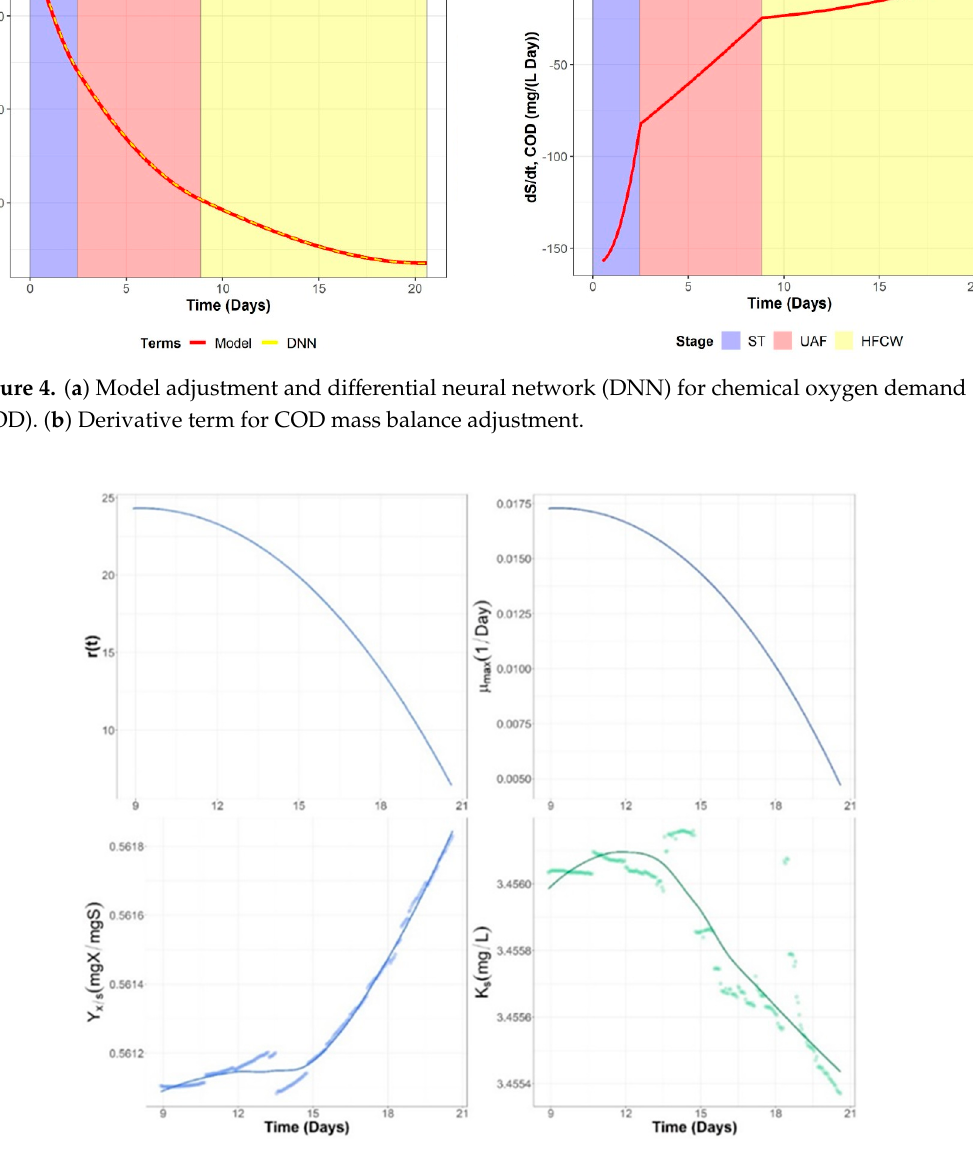
Table 6. Mean values and standard deviation for 𝑌 (cid:3051)/(cid:3046) (mg biomass/mg substrate), 𝐾 (cid:3046) (mg/L), and 𝜇 (cid:3040)(cid:3028)(cid:3051) (h − 1 ) obtained from mass balance models.